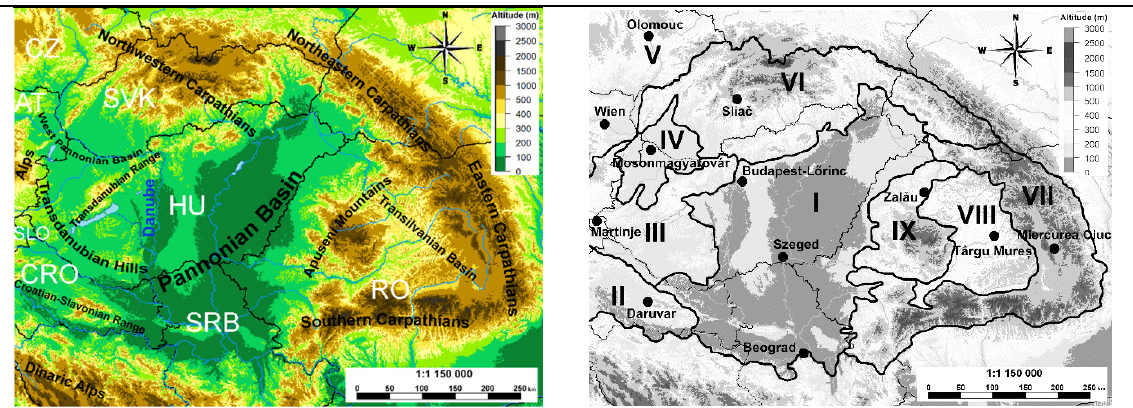
Figure 1. The Pannonian Basin with major orographic and river systems. The abbreviation of the names of the targeted countries ( left ) and the climatic sub regions with the selected stations for the analysis ( right ).